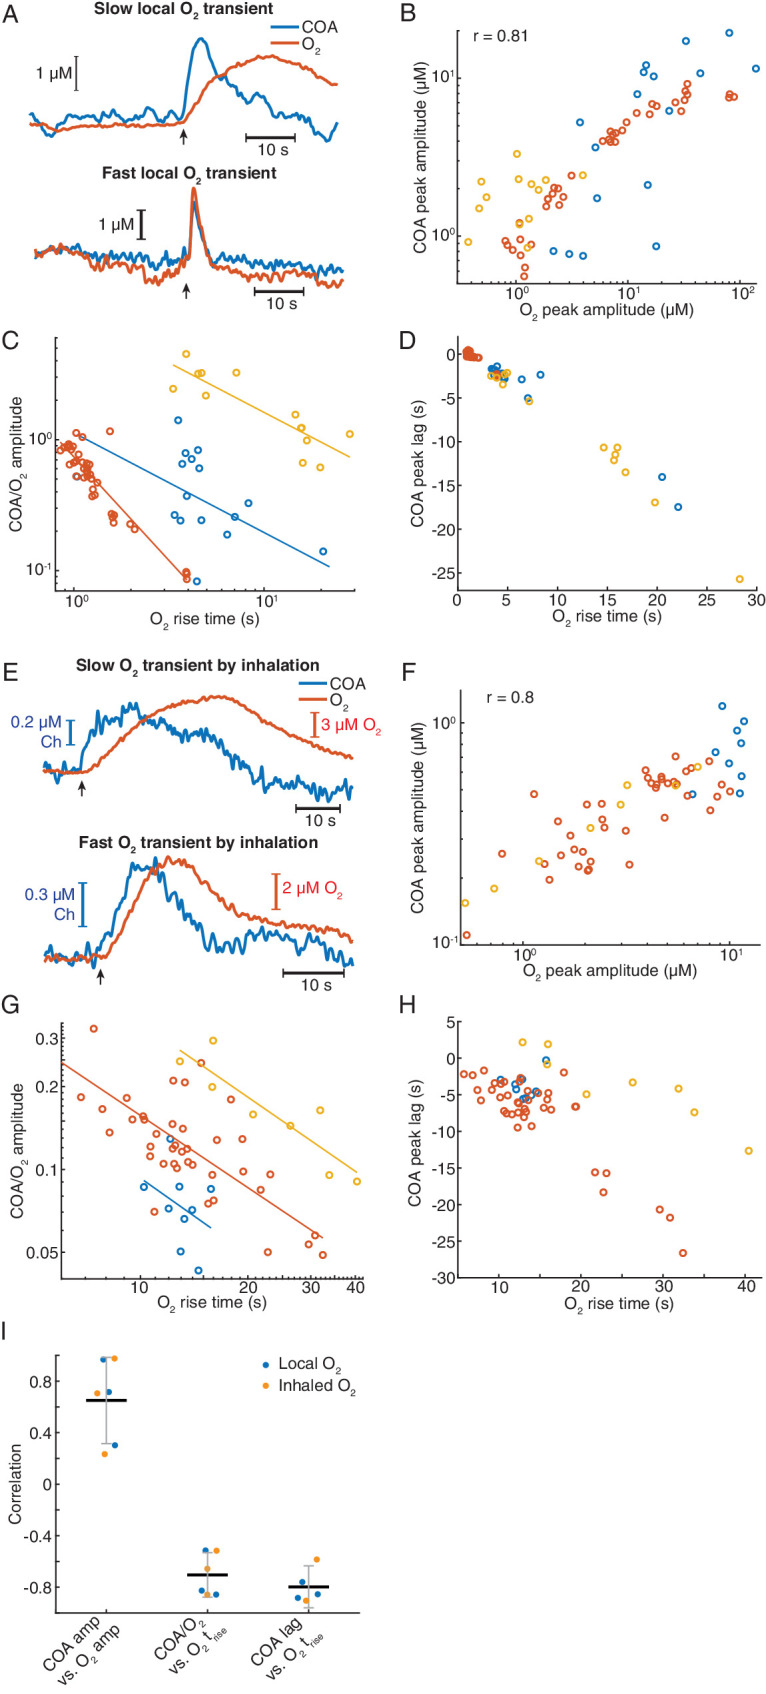
Exogeneous O2 elicits phasic COA responses in the hippocampus in vivo.(A) Representative examples of slow and fast O2 transients and associated COA responses evoked by local application of exogenous O2 from a glass micropipette. (B) Amplitudes of COA vs. locally evoked O2 transients. Data are from three recordings (color-coded, n = 13–40 per session). Amplitudes were significantly correlated when pooling all data (rspearman = 0.81, p<0.0001) and within two sessions (p=0.0017 and p<0.0001, analysis not performed in one session due to the narrow range of O2 amplitudes covered). (C) Ratio of COA vs. evoked O2 peak amplitudes as a function of O2 signal rise time. Colors denote recording sessions and trendlines are linear fits performed on data from each session. In all cases, the variables were negatively correlated (p=0.037, p<0.0001, and p<0.001 for each session). (D) Lag of COA relative to locally evoked O2 transient peaks as a function of O2 rise time. Lags significantly decreased with O2 rise time in all sessions (rspearman for each recording ranged from −0.76 to −0.88, p<0.001). (E) Representative traces showing slow and fast transients evoked by O2 inhalation. E-H plots are analogous to A-D, but for O2-inhalation-induced O2 transients. (F) Amplitudes of COA vs. O2 transients. Data were obtained from three recordings (color-coded, n = 8–40 per session). Whole data as well as data from individual experiments were significantly correlated (p<0.0001 and p<0.0005, respectively). (G) Amplitude ratio of COA vs. O2 transients as a function of O2 rise time. Variables were negatively correlated (red and yellow sessions, with rspearman of −0.66 and −0.86 respectively, p<0.0001 and p=0.011). (H) Lags of COA relative to O2 peaks significantly decreased as a function of O2 rise time (red and yellow sessions, rspearman of −0.58 and −0.90 respectively, p<0.0001 and p=0.0046). Analysis in F-H not performed in one session (blue dots) due to insufficient coverage of O2 amplitudes and rise times. (I) Summary of amplitude and COA-O2 lags correlations for COA and O2 transients evoked by local O2 application and O2 inhalation. Data were obtained from six recording sessions in five mice and are presented as means ± CIs.